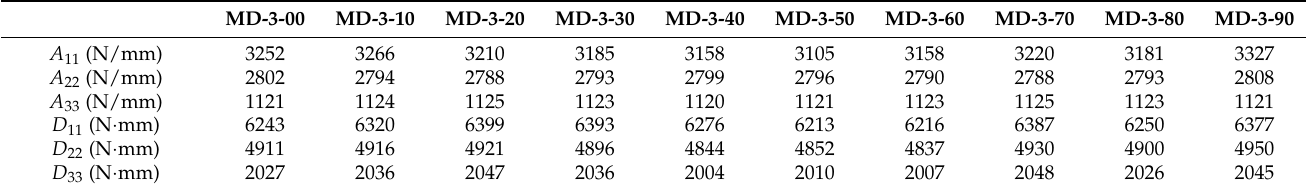
Table 7. The selected stiffnesses with 3% imperfections of compression in the MD shape and with different offsets.